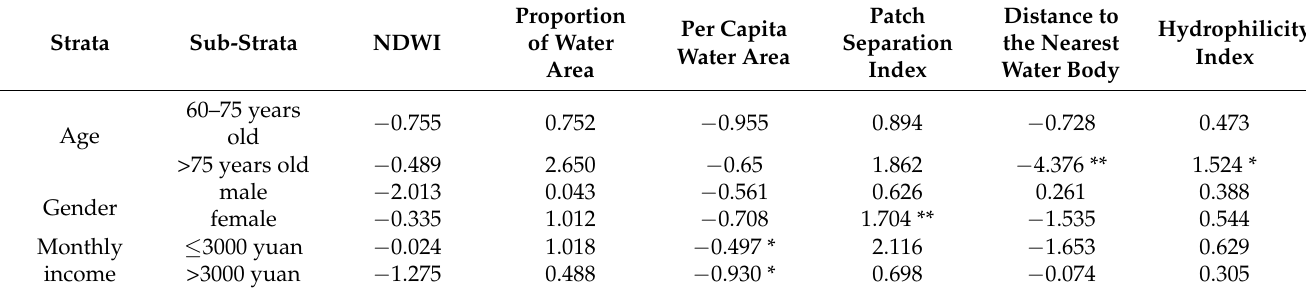
Table 5. Results of stratified multilevel models on the relationship between neighborhood blue space and SRH